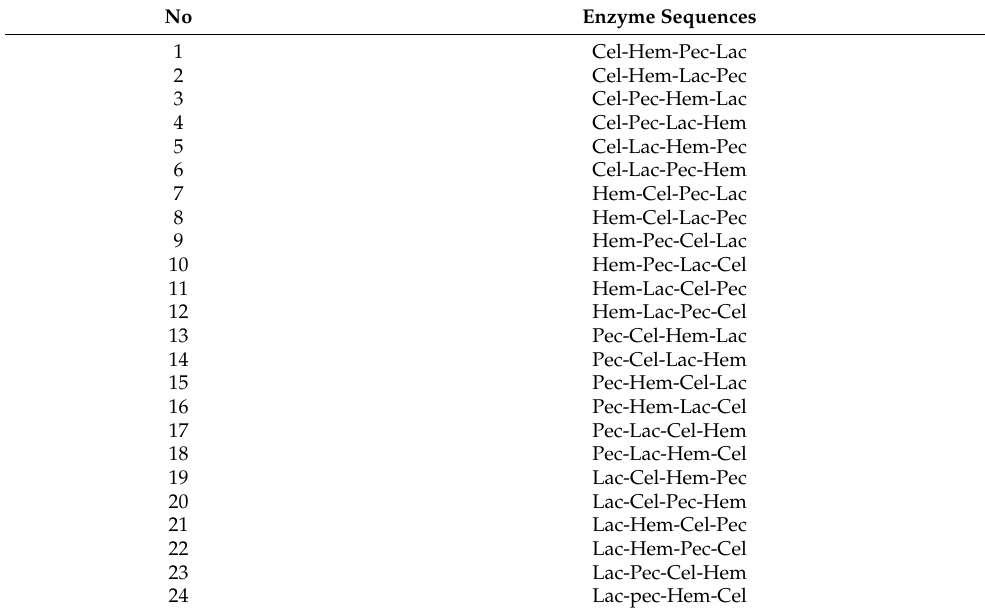
Table 1. The order of fiber-degrading enzymes for four steps degradation of corn stover the